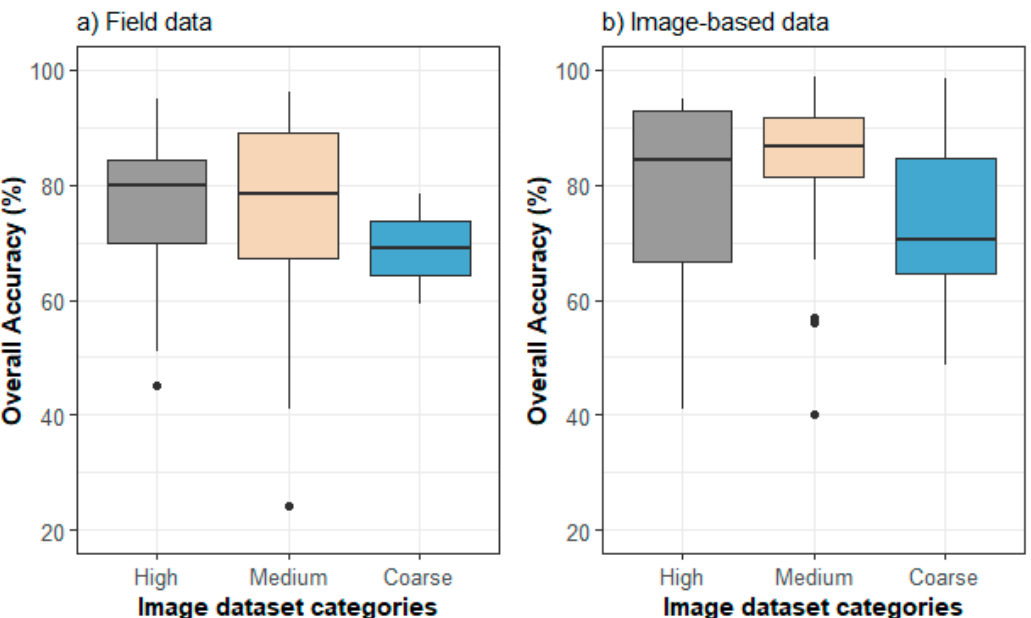
Figure 6. Overall accuracy grouped by the type of image dataset according to spatial resolution used in the classification process, for different types of reference datasets based on ( a ) field data validation (field plots and GPS) and ( b ) image-based validation data (single pixels, pixel cluster, and polygons). High refers to less than 10 m pixel size, Medium 10–30 m pixel size, and Coarse refers to images with more than 30 m in pixel